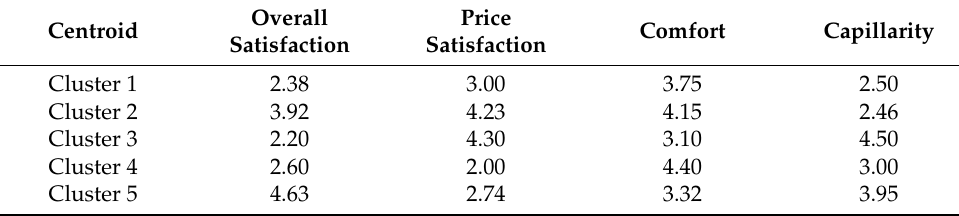
Table 4. Value of cluster centroids